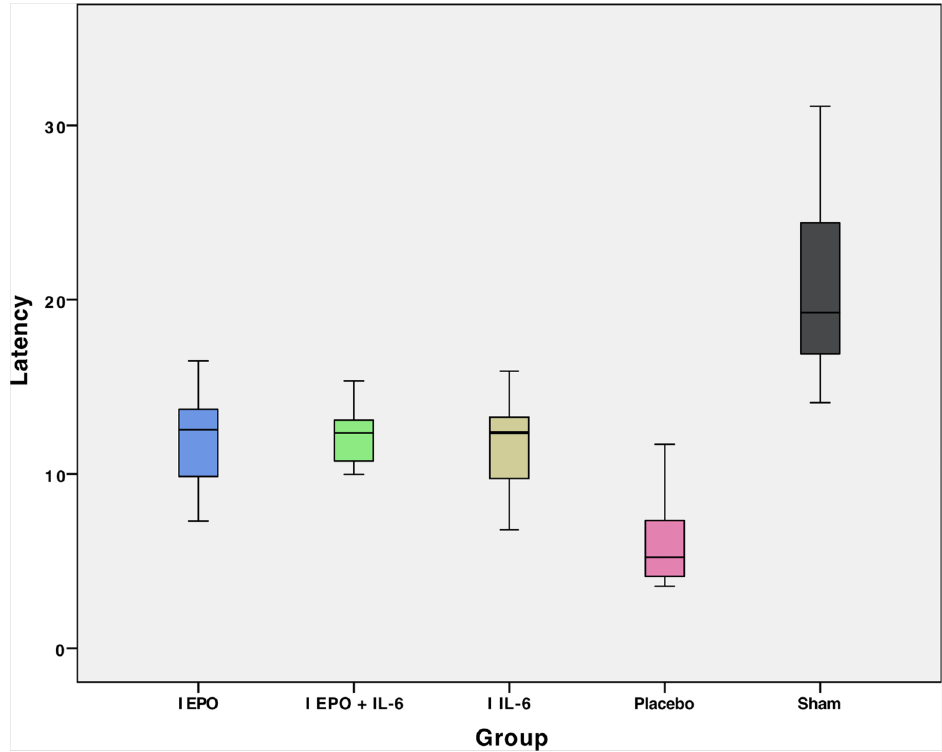
Figure 3 - Mean latency in the motor-evoked potential (MEP) exam of hindlimbs for each group.